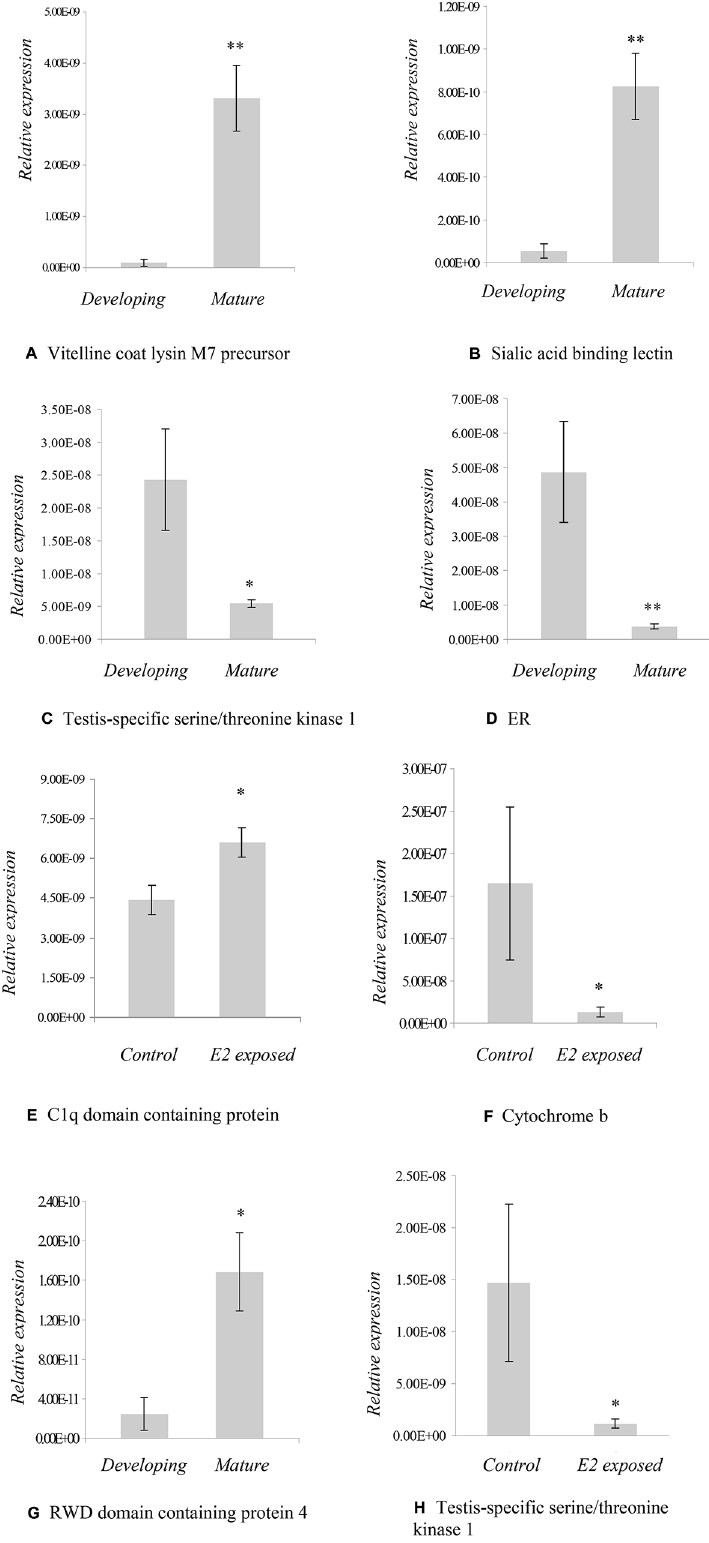
Fig 1. Real-time quantitative RT-PCR validation of differential screening results of M . edulis developing gonad versus mature gonad samples (1A – 1E) and M . edulis experimentally-exposed to E2 (1F – 1H). Data plotted as mean ± SEM, n = 15 samples. * = p < 0.05; ** = p <